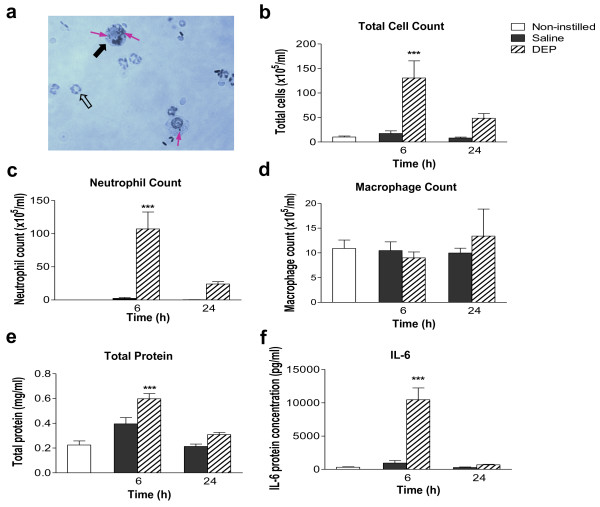
Instillation of diesel exhaust particles (DEP) causes transient pulmonary inflammation. (a) Representative photomicrograph of a cytocentrifuge slide prepared from bronchoalveolar lavage fluid (BALF) collected from a DEP-instilled animal 6 h after instillation. Neutrophils (open arrow) and alveolar macrophages (black arrow) containing particulate (purple arrow) are apparent. Diff-Quick™ staining, ×400 magnification. BALF was analysed for (b) total cell count, (c) neutrophils, (d) alveolar macrophages, (e) total protein (bicinchonic acid assay) and (f) interleukin-6 (IL-6). Non-instilled (open columns), saline-instilled (solid columns) and DEP-instilled (hatched columns) animals 6 and 24 h after instillation. Results are expressed as mean ± SEM (n = 4-8; data for non-instilled groups were pooled, n = 11) ***P < 0.001 DEP versus saline; two-way ANOVA followed by Bonferroni post-hoc test.